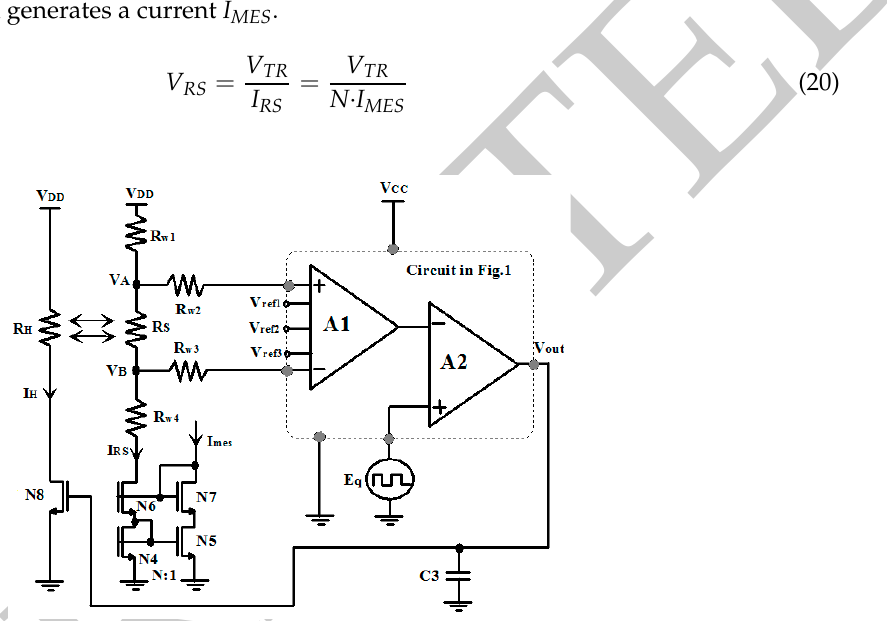
Figure 5. CTA circuit with R w 1 , R w 2 , R w 3 and R w 4 are the wire resistances.